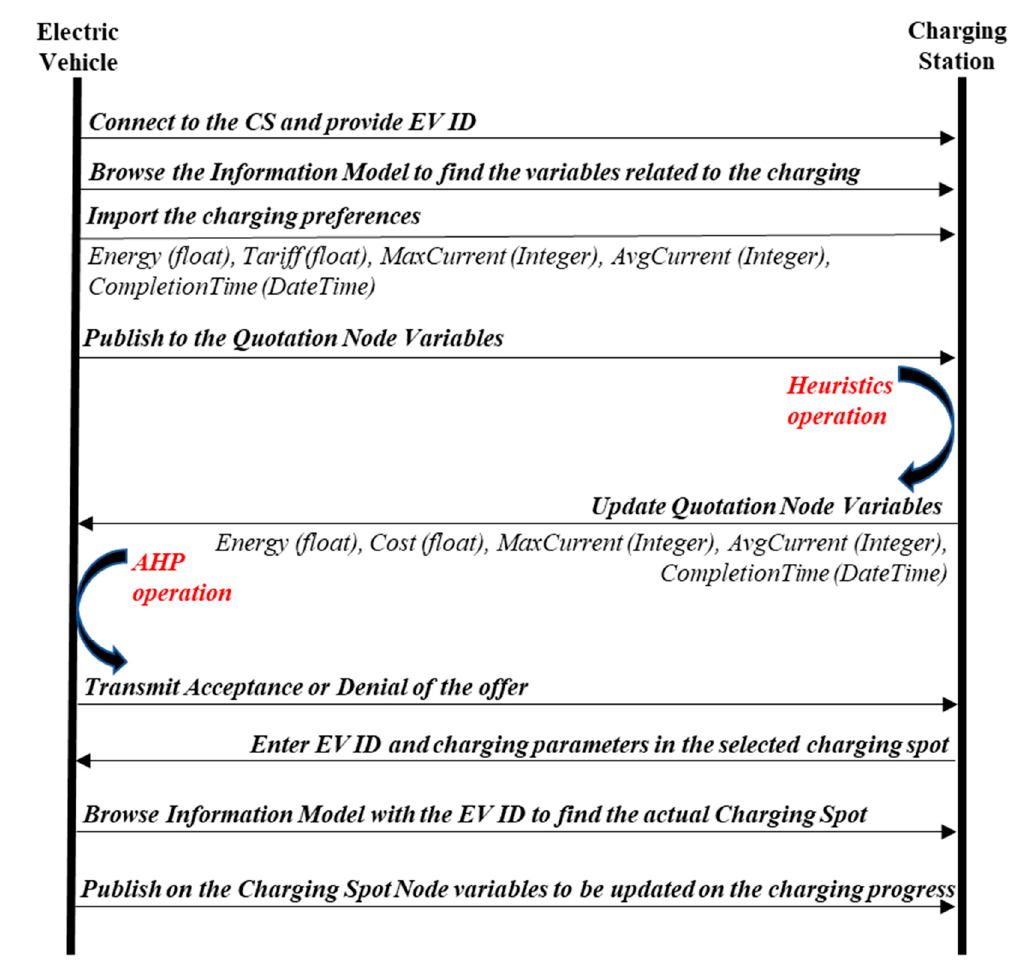
Figure 5. The sequence diagram for the Open Platform Communications–Unified Architecture (OPC–UA) communications.